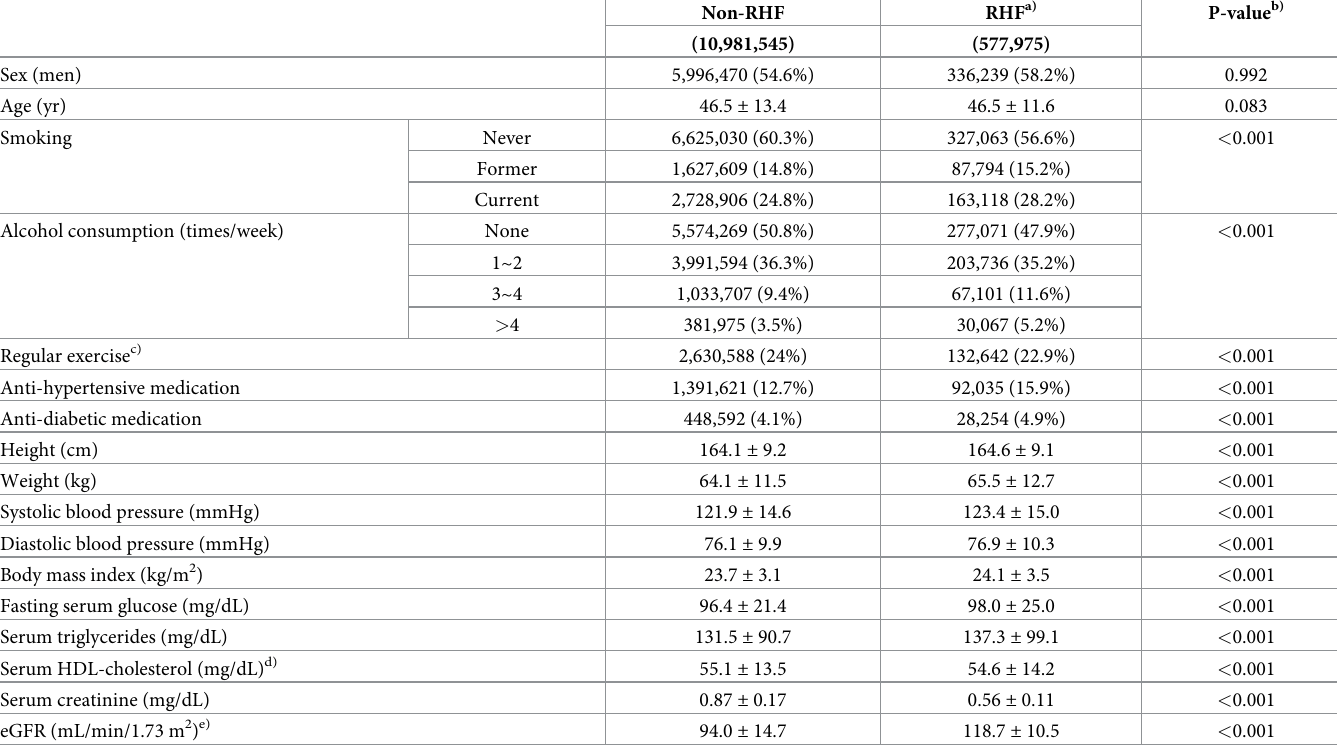
Table 1. General characteristics of the subjects at the initial health